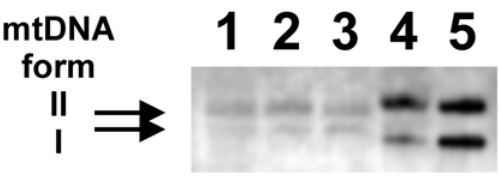
Fig. 1 – Southern blot analysis of mtDNA using a mitochondrial sequence from C. hominivorax . Lanes 1–3, 4 µ g of mtDNA ex- tracted from rat liver mitochondria. Lanes 4–5, 4 µ g of mtDNA extracted from C. hominivorax . mtDNA archetypal conforma- tions: supercoiled (form I) and open relaxed (form